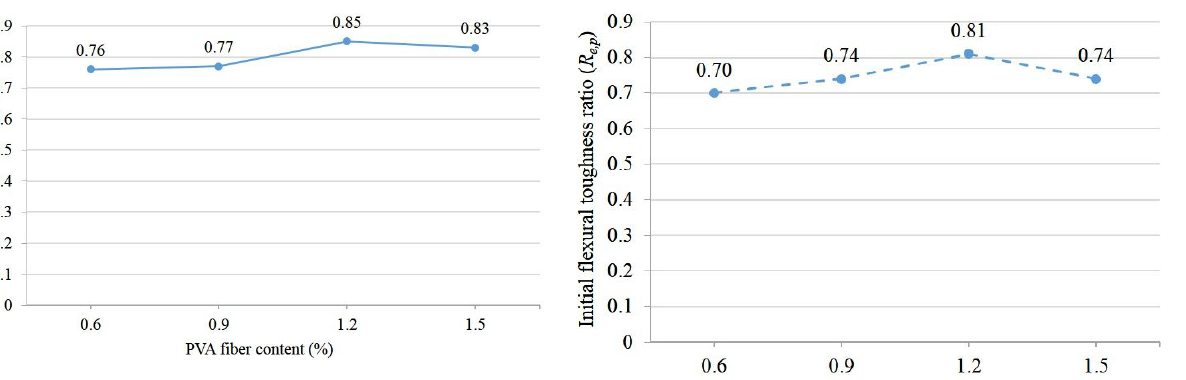
Figure 7: Initial flexural toughness ratio ( R e , p ) of composites with different PVA fiber contents